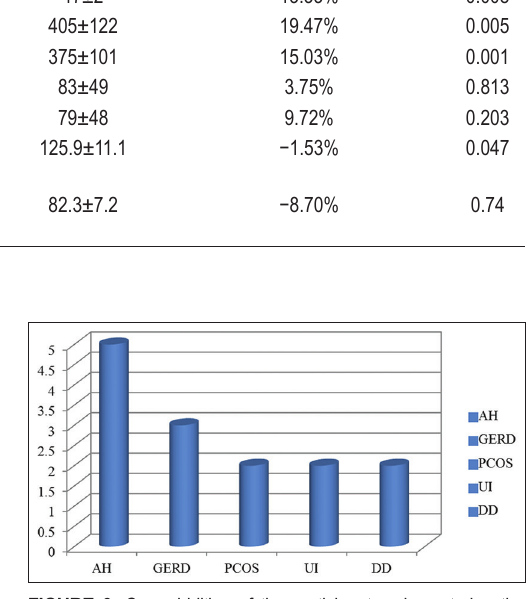
FIGURE 3. Comorbidities of the participants prior entering the training program.